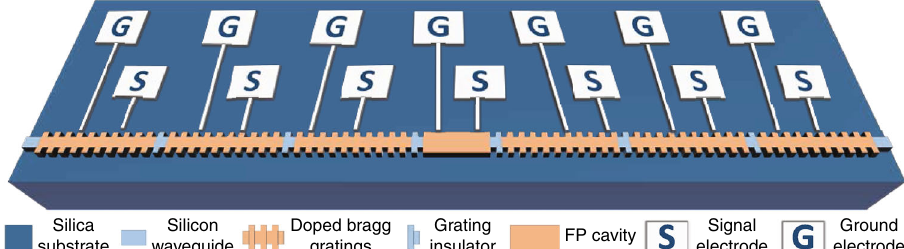
Fig. 1 Schematic view of recon fi gurable grating. The grating consists of multiple series-connected uniform Bragg grating sections and an FP cavity section in the center of the grating. Each uniform Bragg grating section incorporates an independent lateral PN junction, and between two neighboring sections there is an un-doped grating to function as an insulator. A pair of electrodes (Signal and Ground) are connected to each independent PN